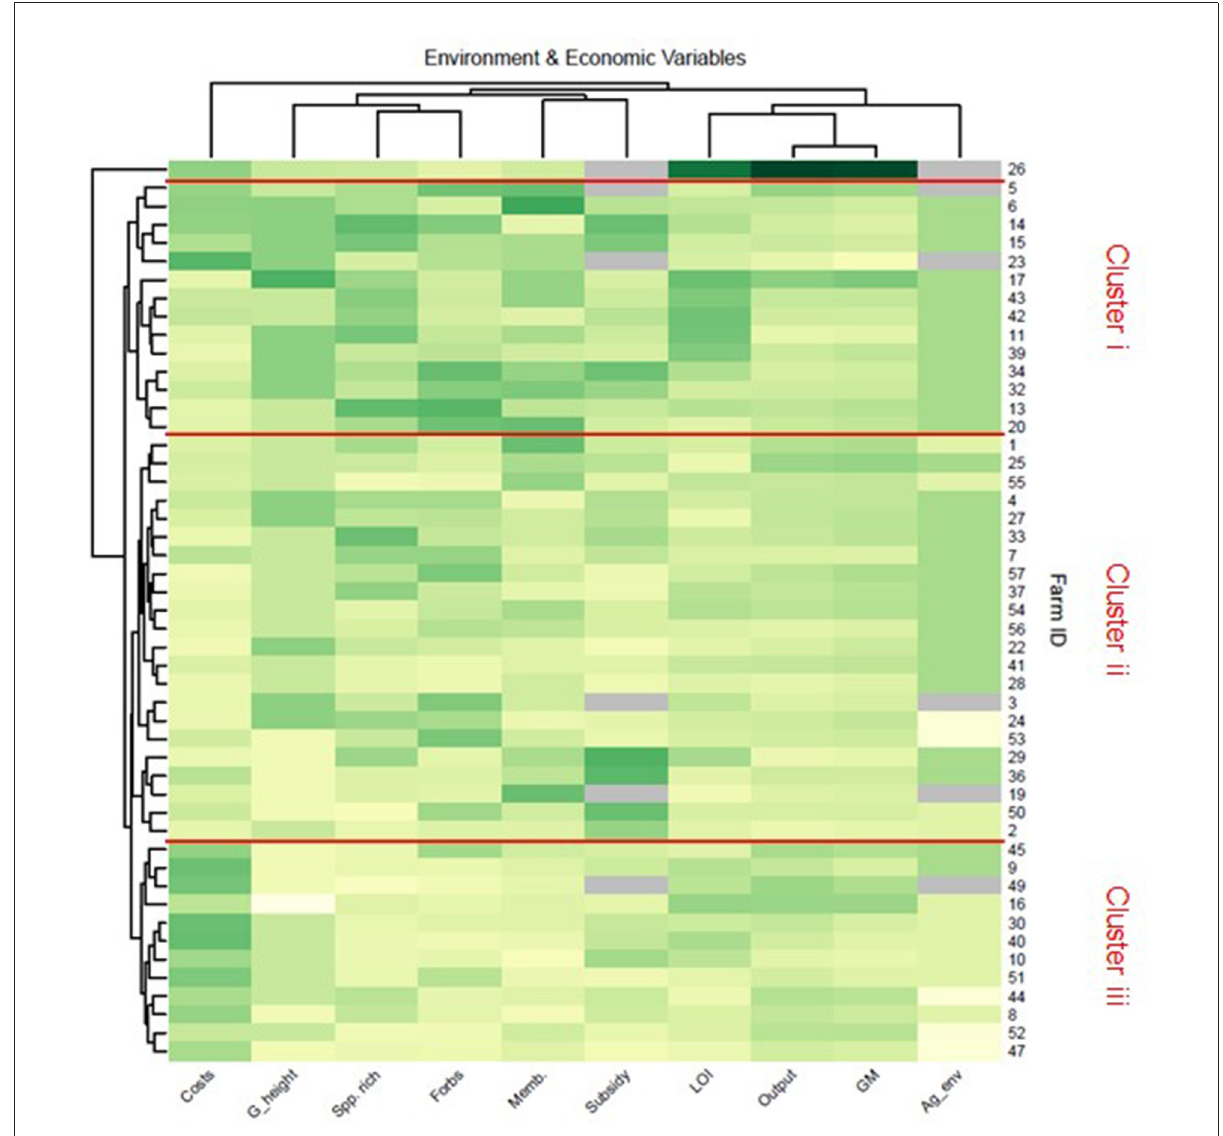
FIGURE6 Heatmap of variables within the Economic and Environmental categories collected as part of the PG tool and field data collection. Farms are clustered by color where they have similar values (i.e., farms with higher values have darker colors across all columns). Variables include; Costs, variable costs per livestock unit; G_height, height of grassland; Spp. rich, species richness; Forbs, forbs coverage; Memb, duration of PFLA membership in years; Subsidy, total amount of subsidy received as % of total income; LOI, Loss On Ignition (derived soil organic matter %); Output, financial output per livestock unit; GM, Gross margin per livestock unit; Ag_env, Level of agri-environment scheme participation (1–3).